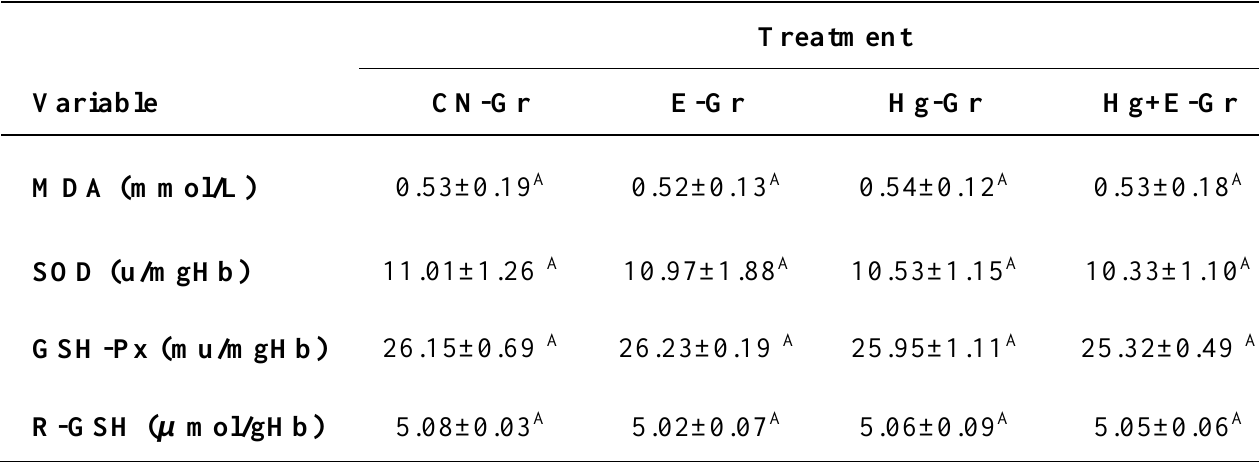
Table 1 . Serum malondialdehyde (MDA) concentration, reduced glutathione content, superoxide dismutase (SOD) and glutathione peroxidase (GSH-Px) activities in rats on day 0 1